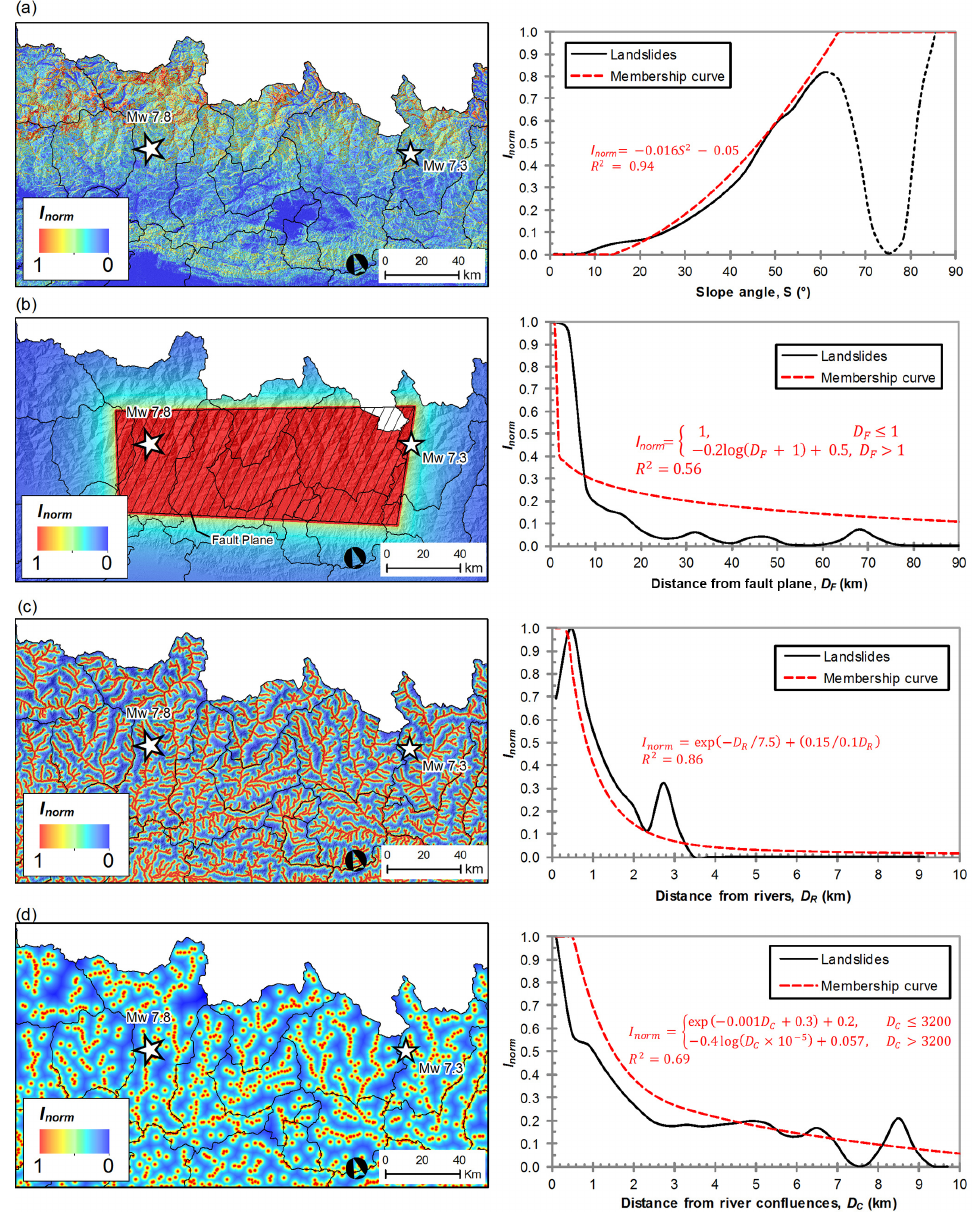
via the area under receiver operating characteristic (ROC) curves. The ROC curve is a fundamental tool for evaluating model accuracy and plots the true positive rate of the model against the false positive rate using various cut-off values (Metz, 1978; Zweig and Campbell, 1993). Landslides occur- ring in cells with H LS values above the cut-off are considered true positives, while cells above the cut-off without land- slides are considered false positives. To be considered suc- cessful, models must typically achieve area under the curve (AUC) values > 0.7 (Kritikos et al.,